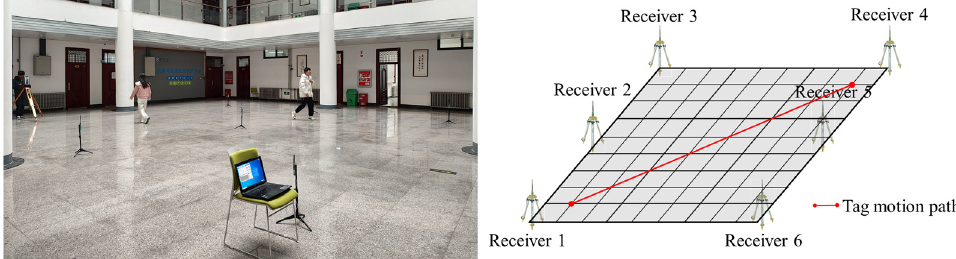
Figure 12. The experimental scene and tag movement trajectory.